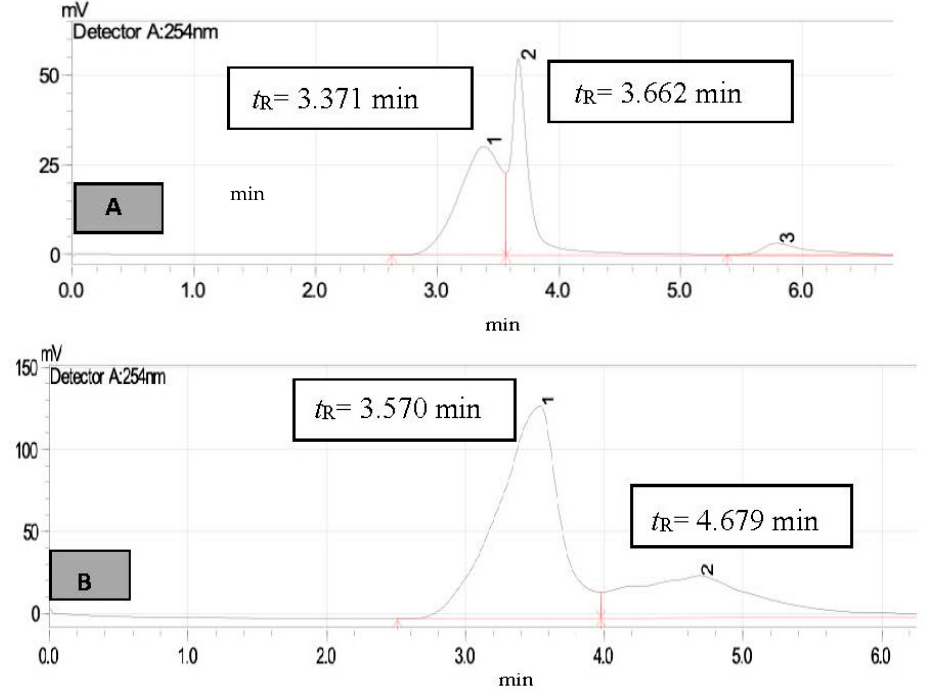
Figure 9. HPLC chromatogram of FSIE ( A )—untreated sample ( B )—treated sample, peak 1 for N ‐ methylaniline ( t R = 3.570 min) and peak 2 ( t R = 4.679 min) for unknown compounds.